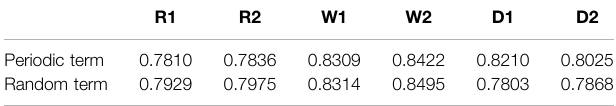
TABLE1| GRAresultsbetweenthedisplacementperiodicandrandomtermsand the in fl uencing factors.